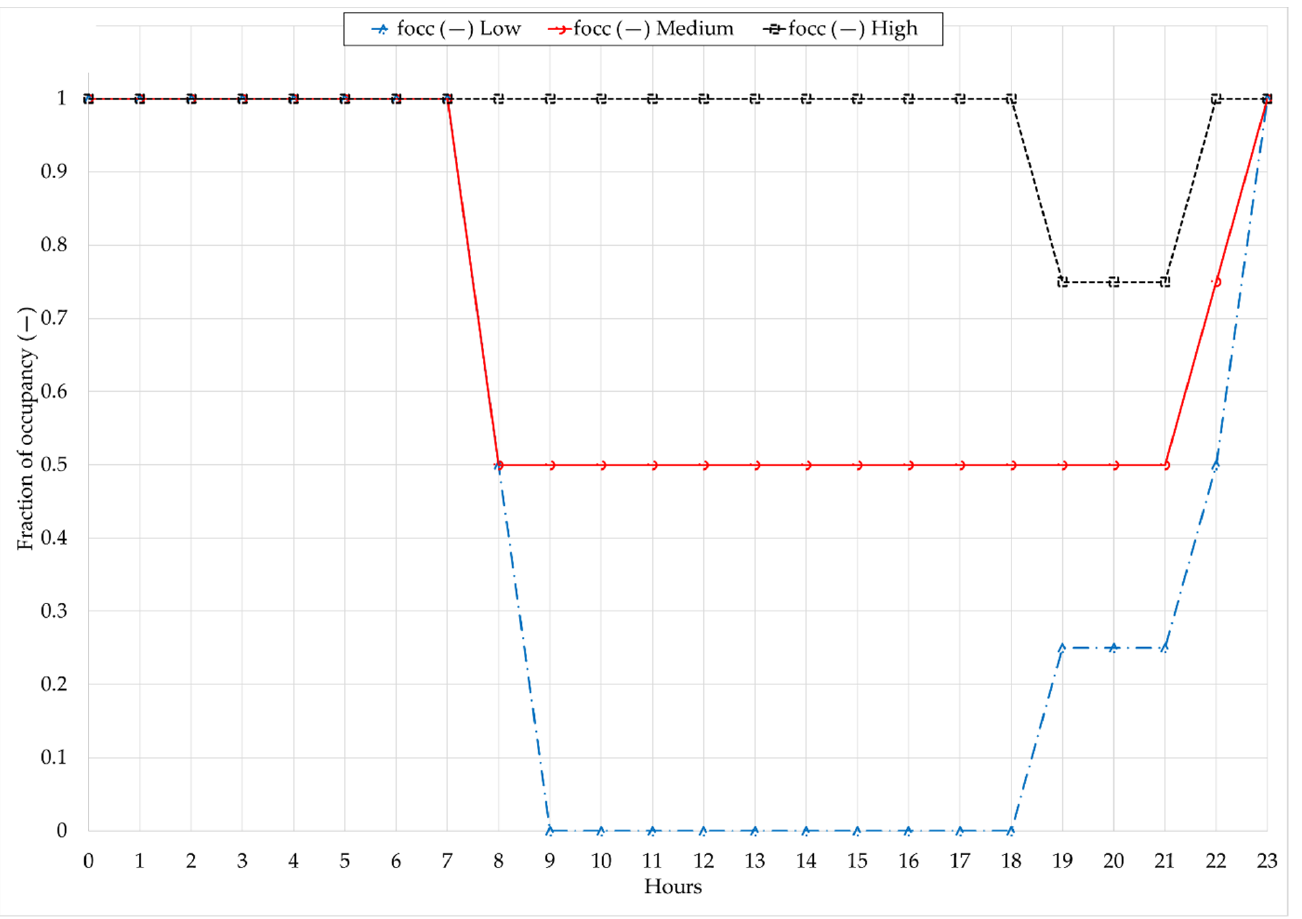
Figure 6. Occupancy fraction profiles for the different scenarios analysed (low, medium, and high).